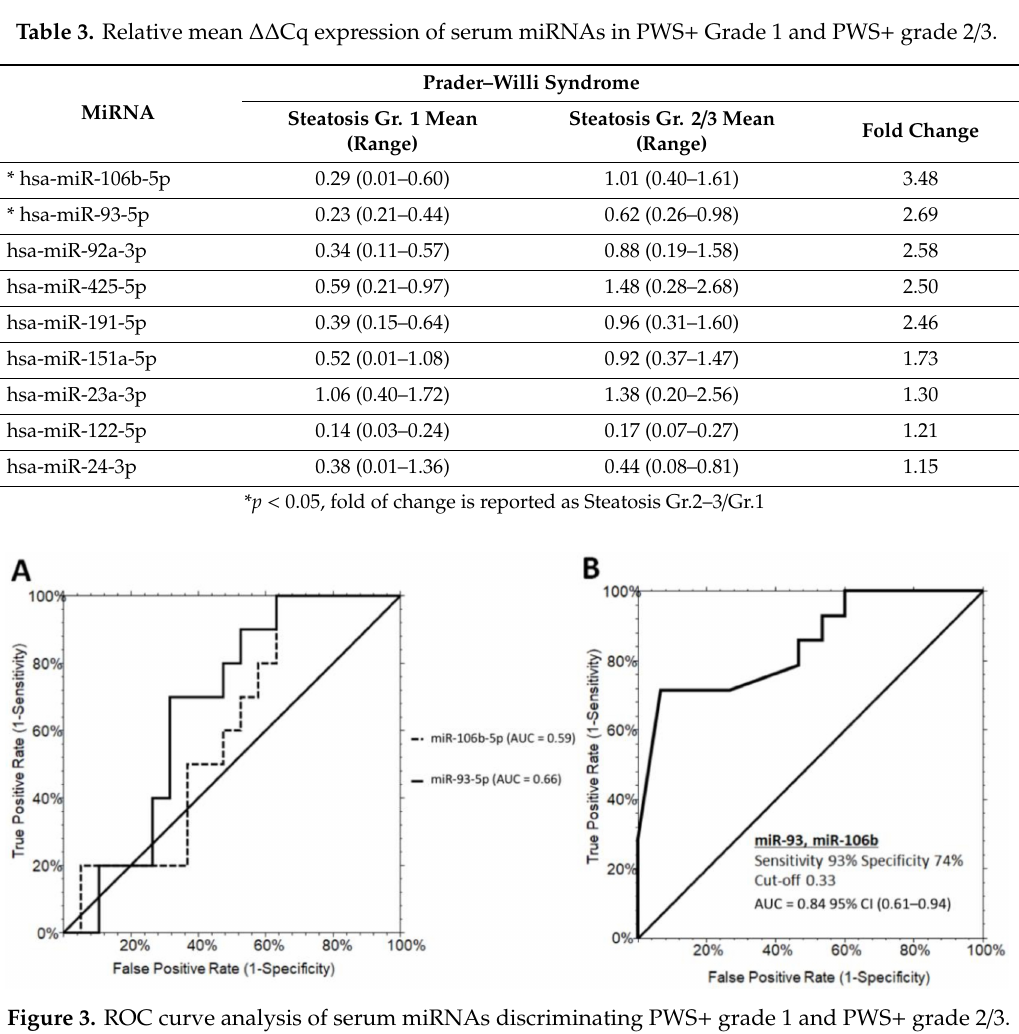
Figure 3. ROC curve analysis of serum miRNAs discriminating PWS + grade 1 and PWS + grade 2 / 3. ( A ) ROC curves for miR-93-5p (60% sensitivity and 52% specificity) and miR-106b-5p (70% sensitivity and 68% specificity). ( B ) ROC curves illustrating the performance of the miRNA panel in discriminating grade 1 from grade 2 / 3 steatosis in PWS + . PWS + , Prader–Willi Syndrome with steatosis AUC, area under the ROC curve; CI, confidence